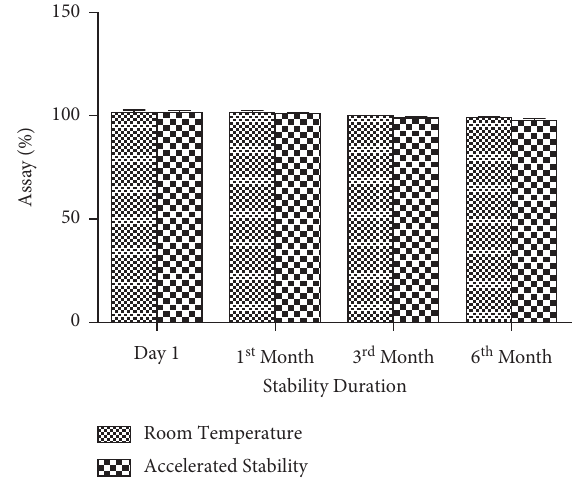
Figure 9: Comparative assay of SRP between room temperature and accelerated stability.